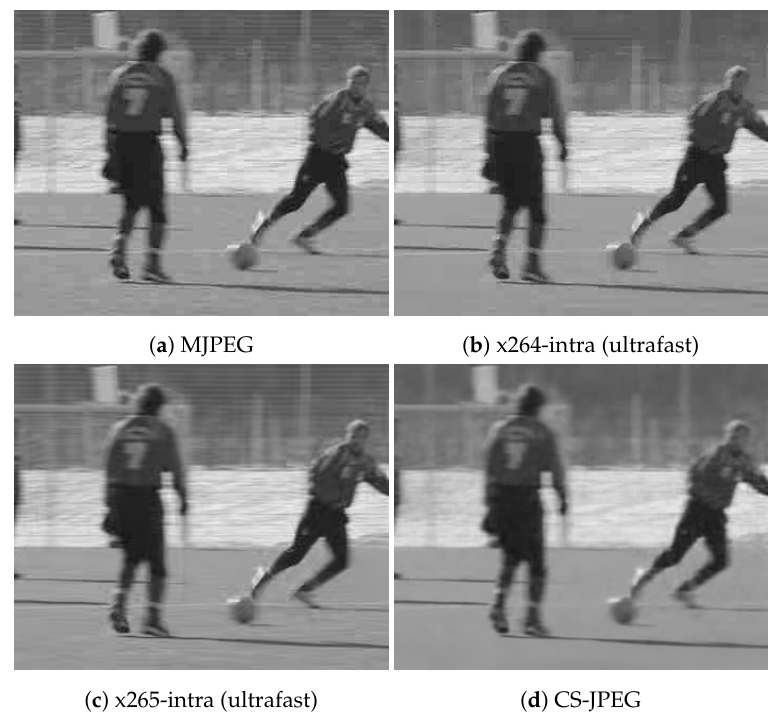
Figure 14. Frame with index 150 at R T = 600 kbps for